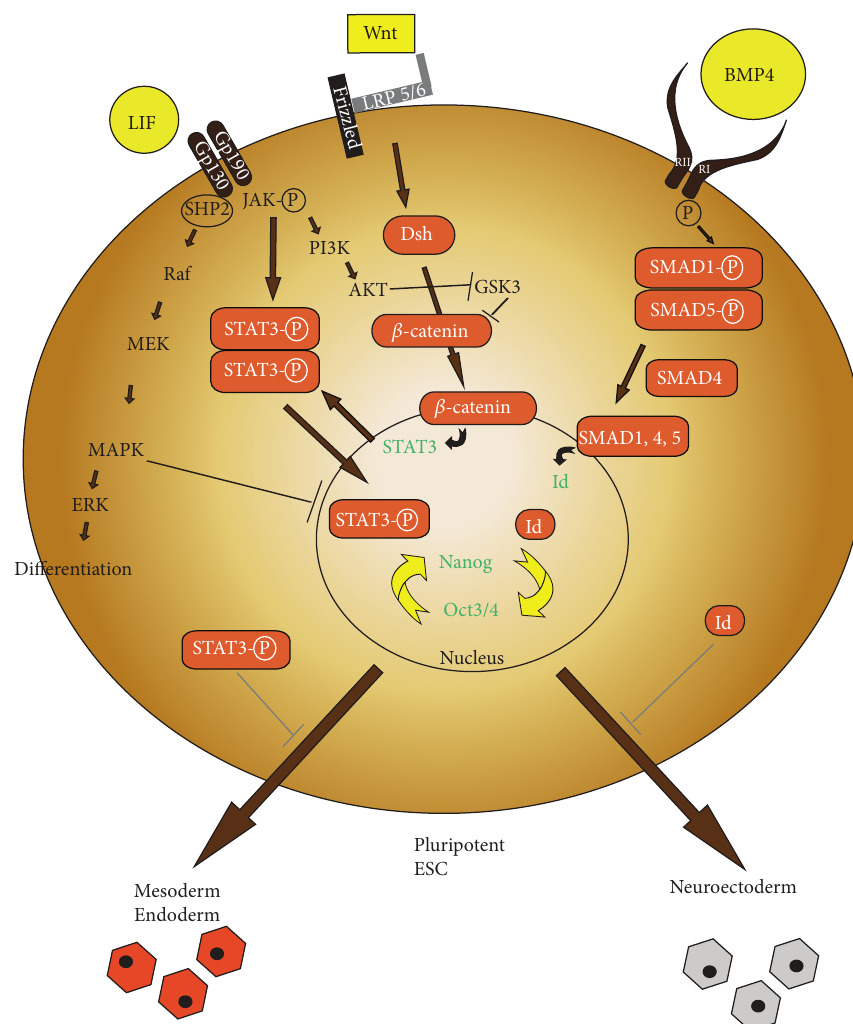
Figure 1: Signalling pathways regulating pluripotency in mESCs. A schematic representation of the main extrinsic pathways (LIF, BMP, and WNT) regulating pluripotency in mESCs. Upon LIF binding to its receptor, Gp130 phosphorylates JAK, which in turn phosphorylates STAT3. Phosphorylated STAT3 operates as a transcription factor which sustains the pluripotency state in mESCs and further inhibits endodermal and mesodermal differentiation. LIF further inhibits GSK3 via PI3K. GSK3 stabilises the self-renewal state by reducing